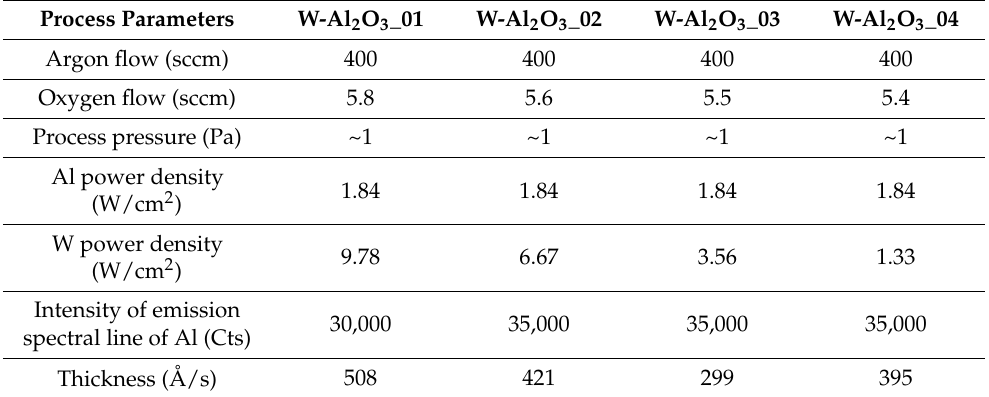
Table 2. Process parameters and thickness evaluations for cermet samples obtained by varying the power density applied to the W target and keeping a fixed power density applied to the Al targets. Process